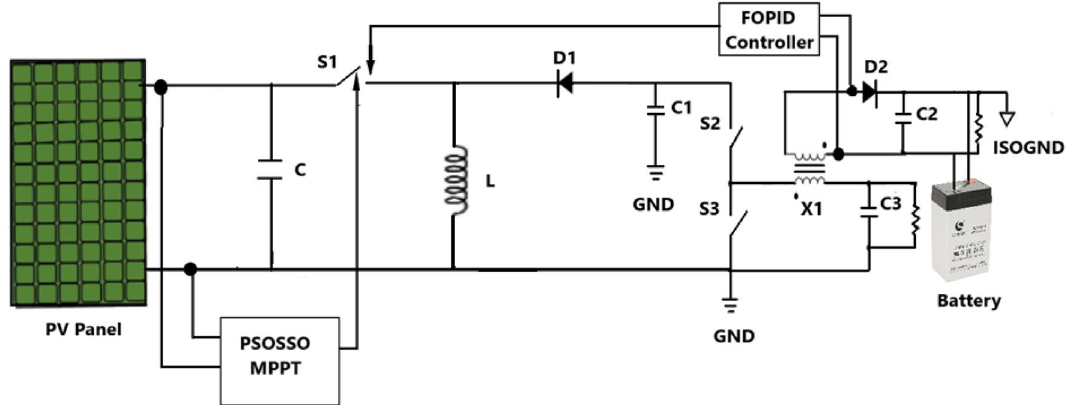
Figure 1. The circuit diagram of the proposed PSOSSO